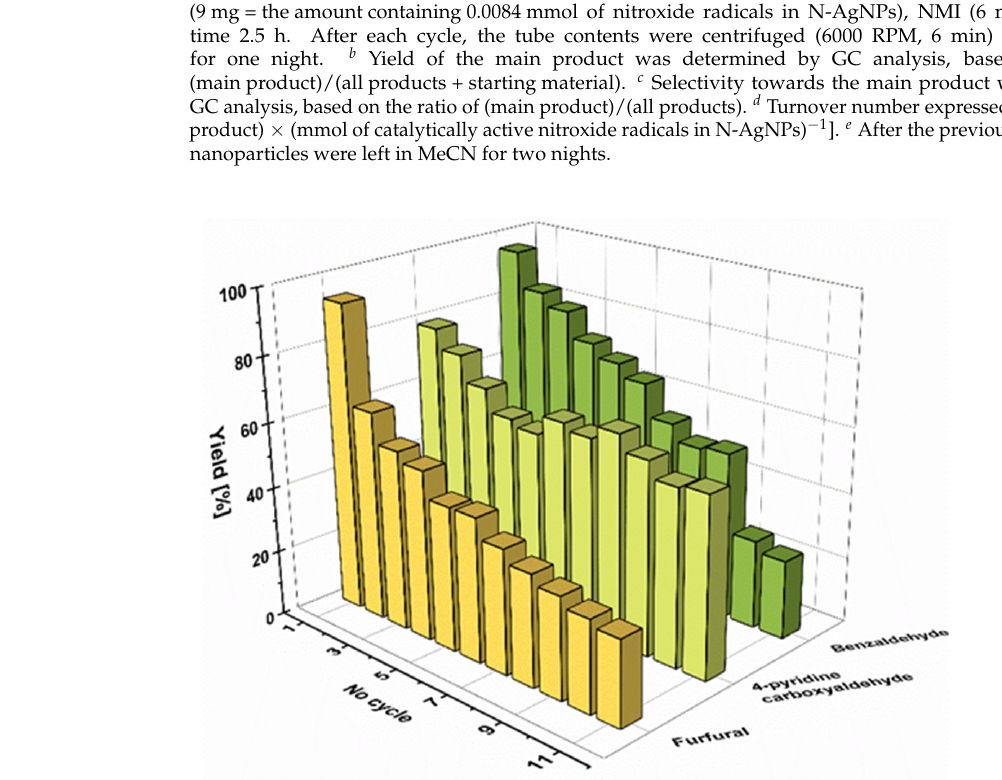
Figure 5. The yields of benzaldehyde, 4-pyridinecarboxaldehyde and furfural in eleven consecutive cycles using N-AgNPs (performed according to the description in Table 4). Table 4. The reusability of N-AgNPs in catalytic oxidation of selected primary aromatic alcohols to aldehydes a .